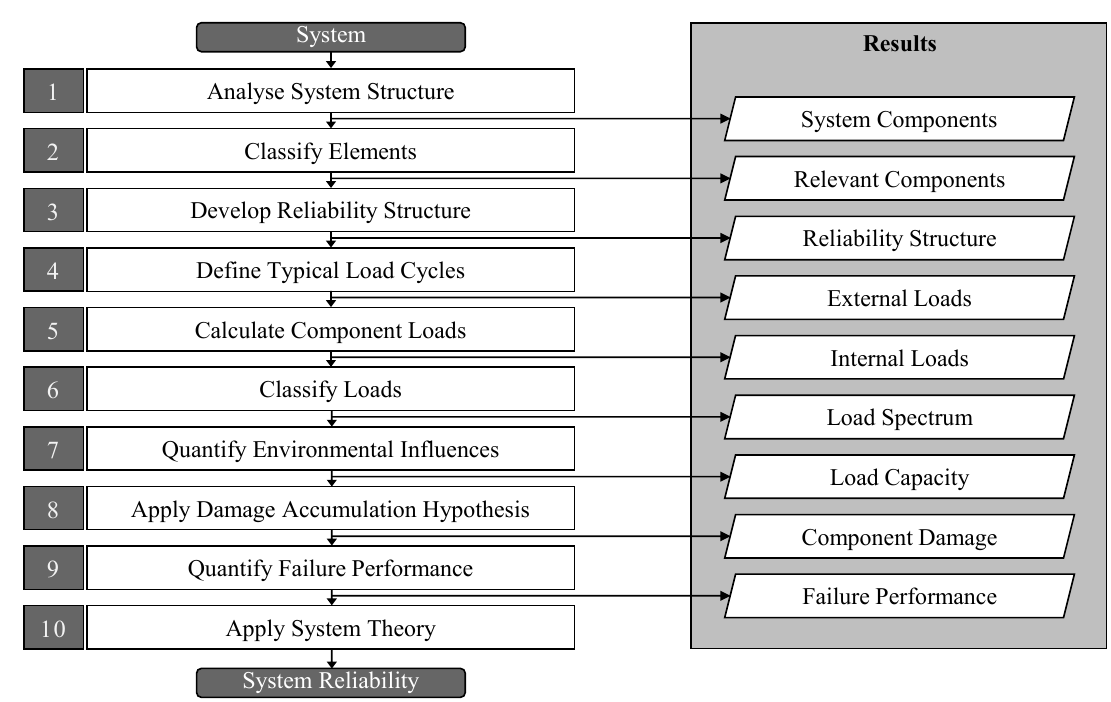
Figure 8: Method for reliability evaluation of technical